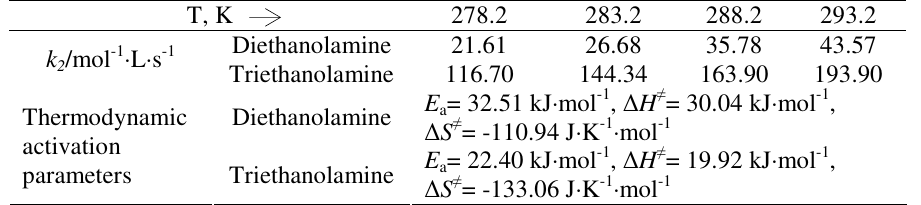
Table 1. Rate constants ( k ) and Thermodynamic activation parameters of the rate- 2 determining step (T=298.2K)